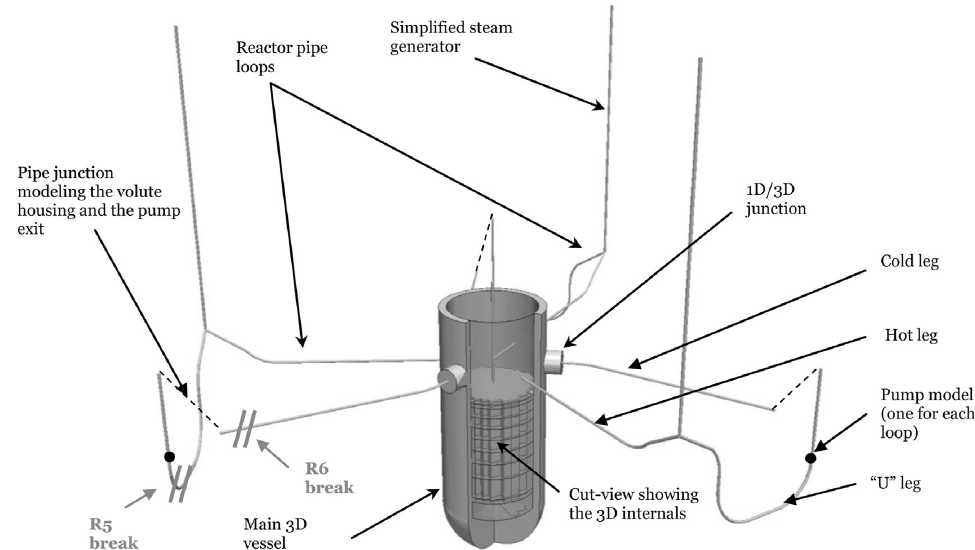
Figure 4. Simplified 1D/3D scheme of a PWR in a loss of cooling accident (LOCA) context—reproduced from [1] with